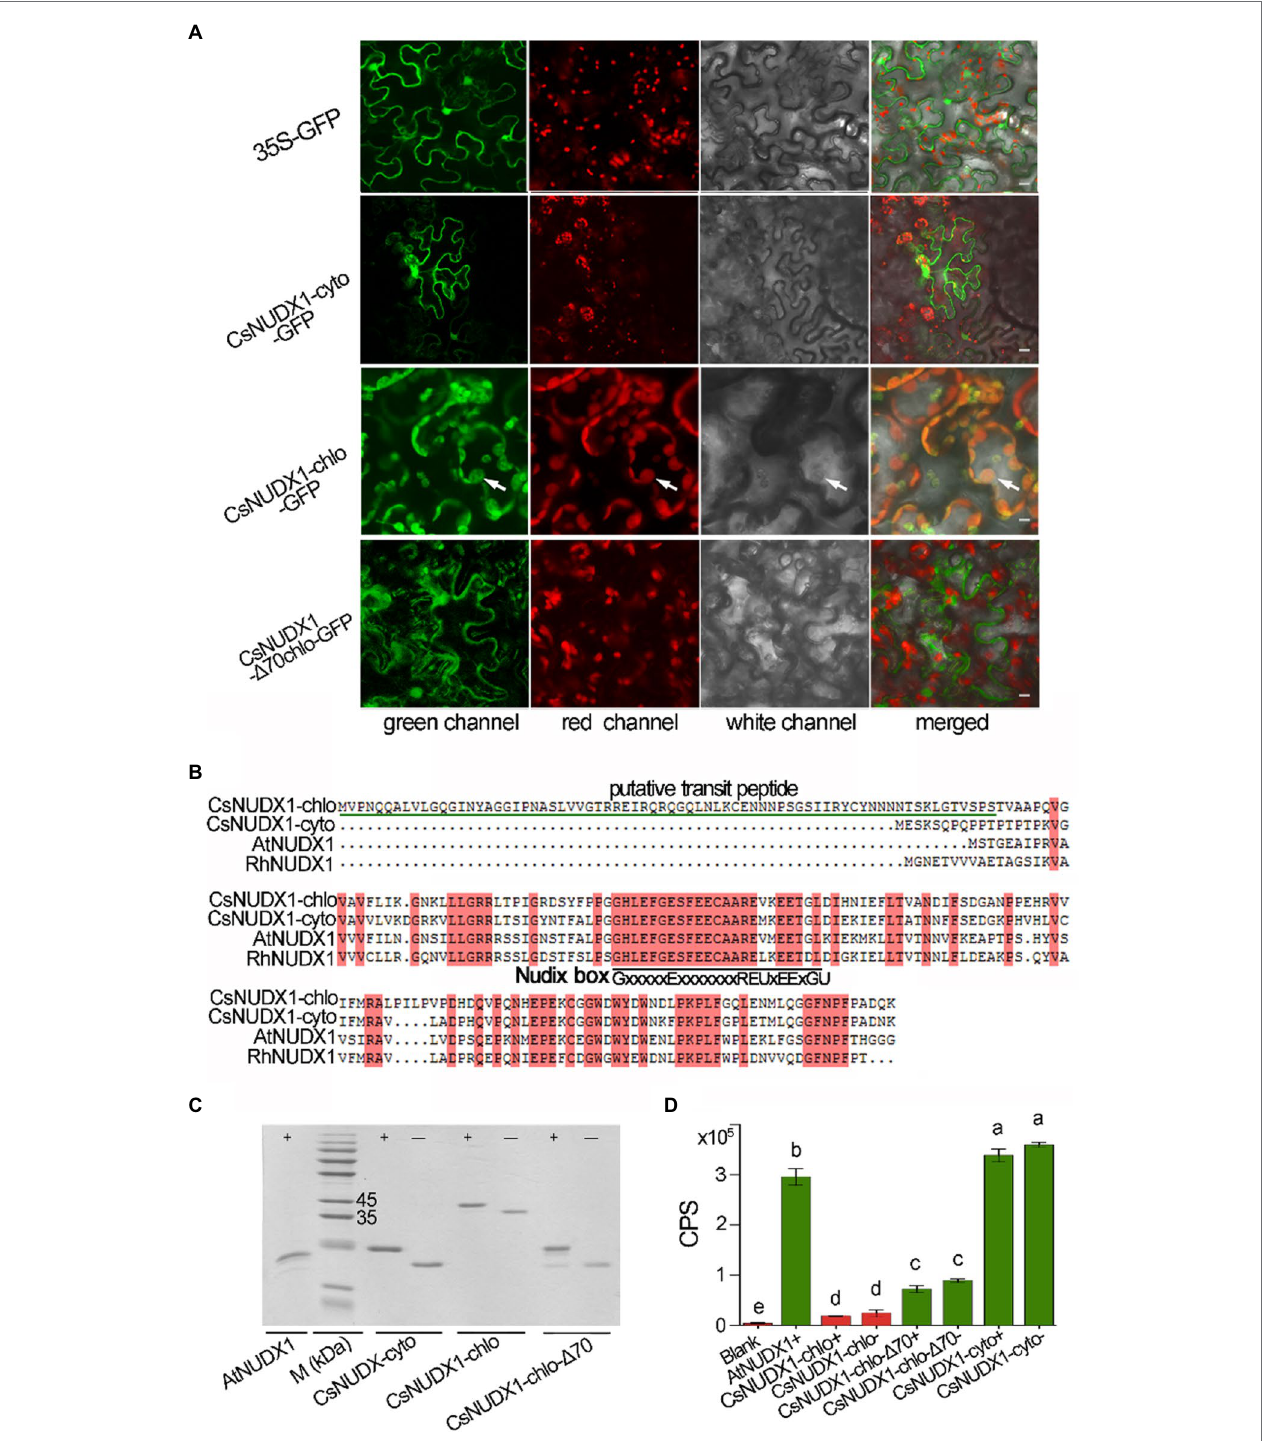
FIGURE 3 | Characterization of CsNUDX1-cyto and CsNUDX1-chlo . (A) Subcellular localization analyses using CsNUDX1 fused with green fluorescent protein mGFP5 (GenBank U87973.1). White arrows indicate chloroplasts. All constructs were expressed in abaxial leaf surface except CsNUDX1-chlo-GFP expressed in adaxial surface. 35S-GFP, GFP gene alone driven by 35S promoter; CsNUDX1- Δ 70chlo-GFP, GFP fused CsNUDX1-chlo without putative transit peptides. Scale, 10 μ m. (B) Tea proteins aligned with the homologues of Arabidopsis (NP_177044.1) and rose (AFW17224.1). (C) SDS- polyacrylamide gel electrophoresis of Escherichia coli expressed CsNUDX1 with/without His-tag and Arabidopsis AtNUDX1 with His-tag as control. M (kDa), a protein marker (kilo Dalton); CsNUDX1- chlo- Δ 70, CsNUDX1-chlo with deleted the putative transit peptide containing 70 amino acid residues at its N-terminus. (D) The levels of in vitro product